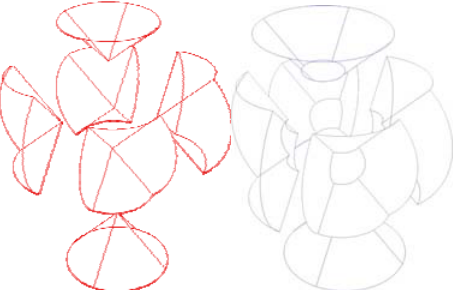
Figure 11. The basic cells of sphere shell volume.